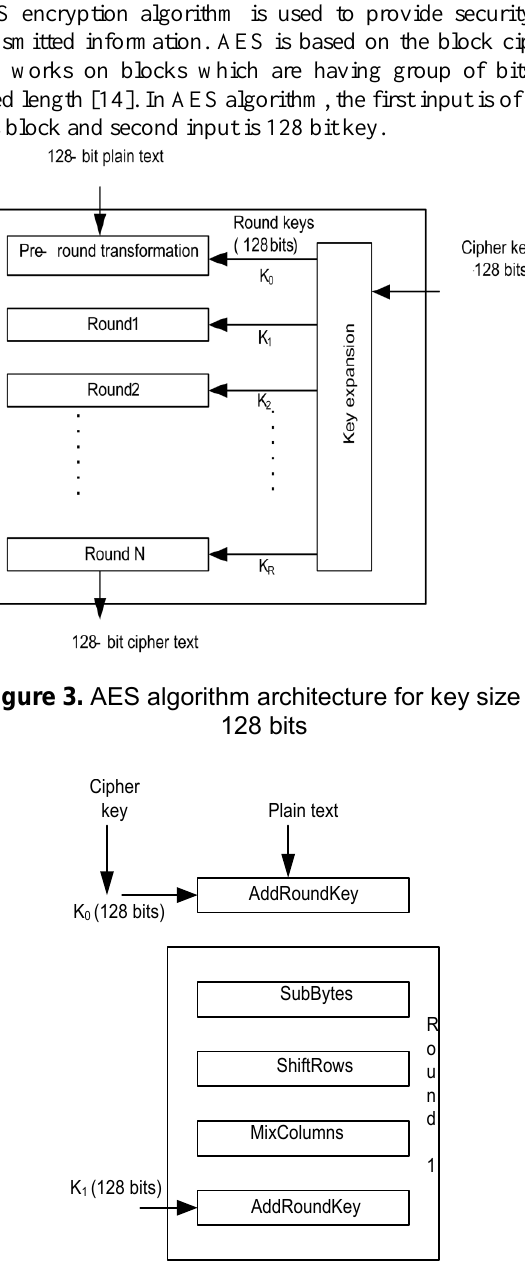
Figure 4. Every round steps in AES encryption algorithm Table 2. Initial permutation on 64 bit plain